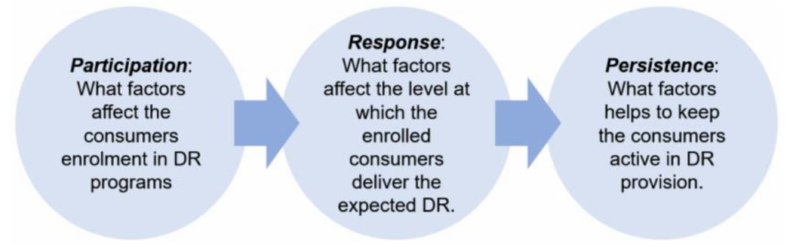
Figure 1. The steps of the engagement of citizens in DR programs according to [14].